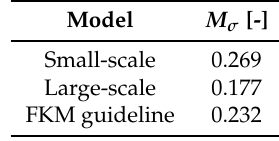
Figure 17. Haigh diagram representing small- and large-scale specimens results. Table 5. Mean stress sensitivities determined by fatigue tests and FKM